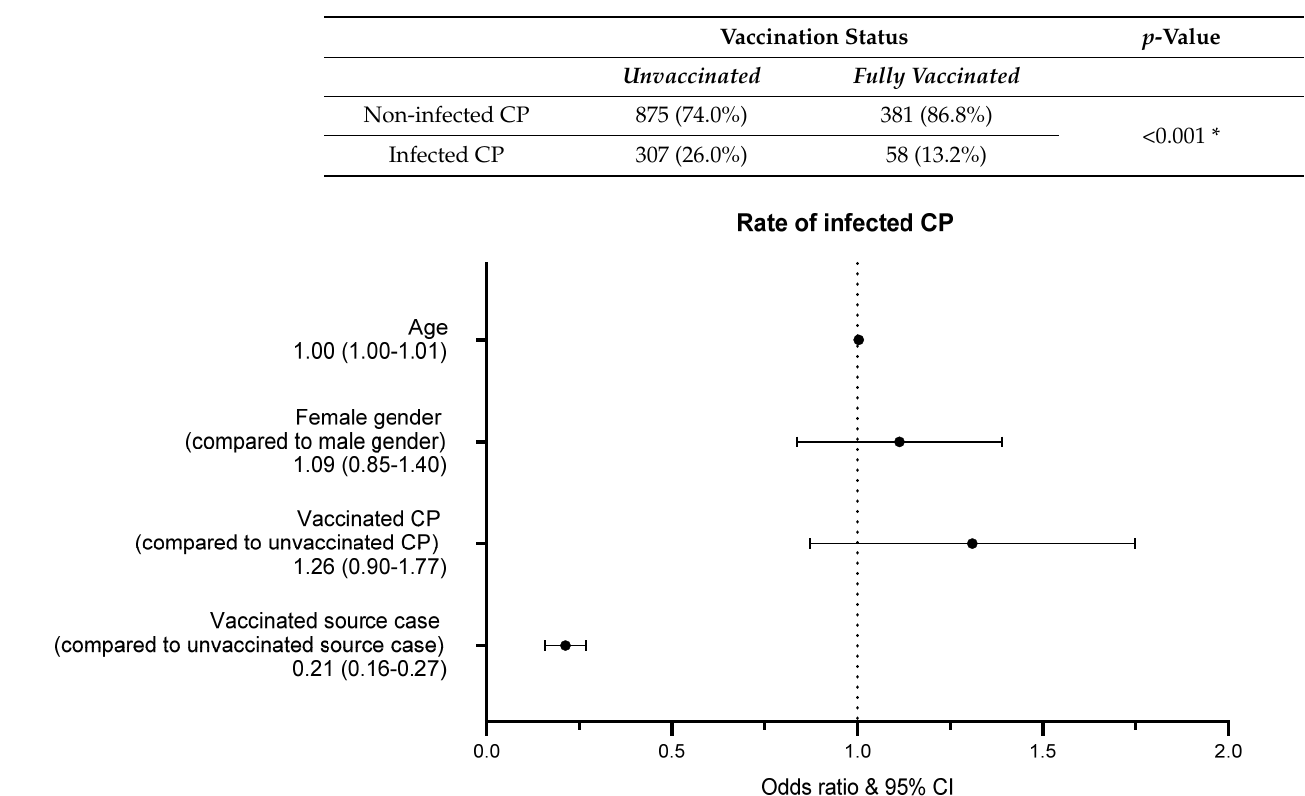
Table 4. Influence of CP (contact person) vaccination status on infection status; * Chi ‐ squared ‐ test.